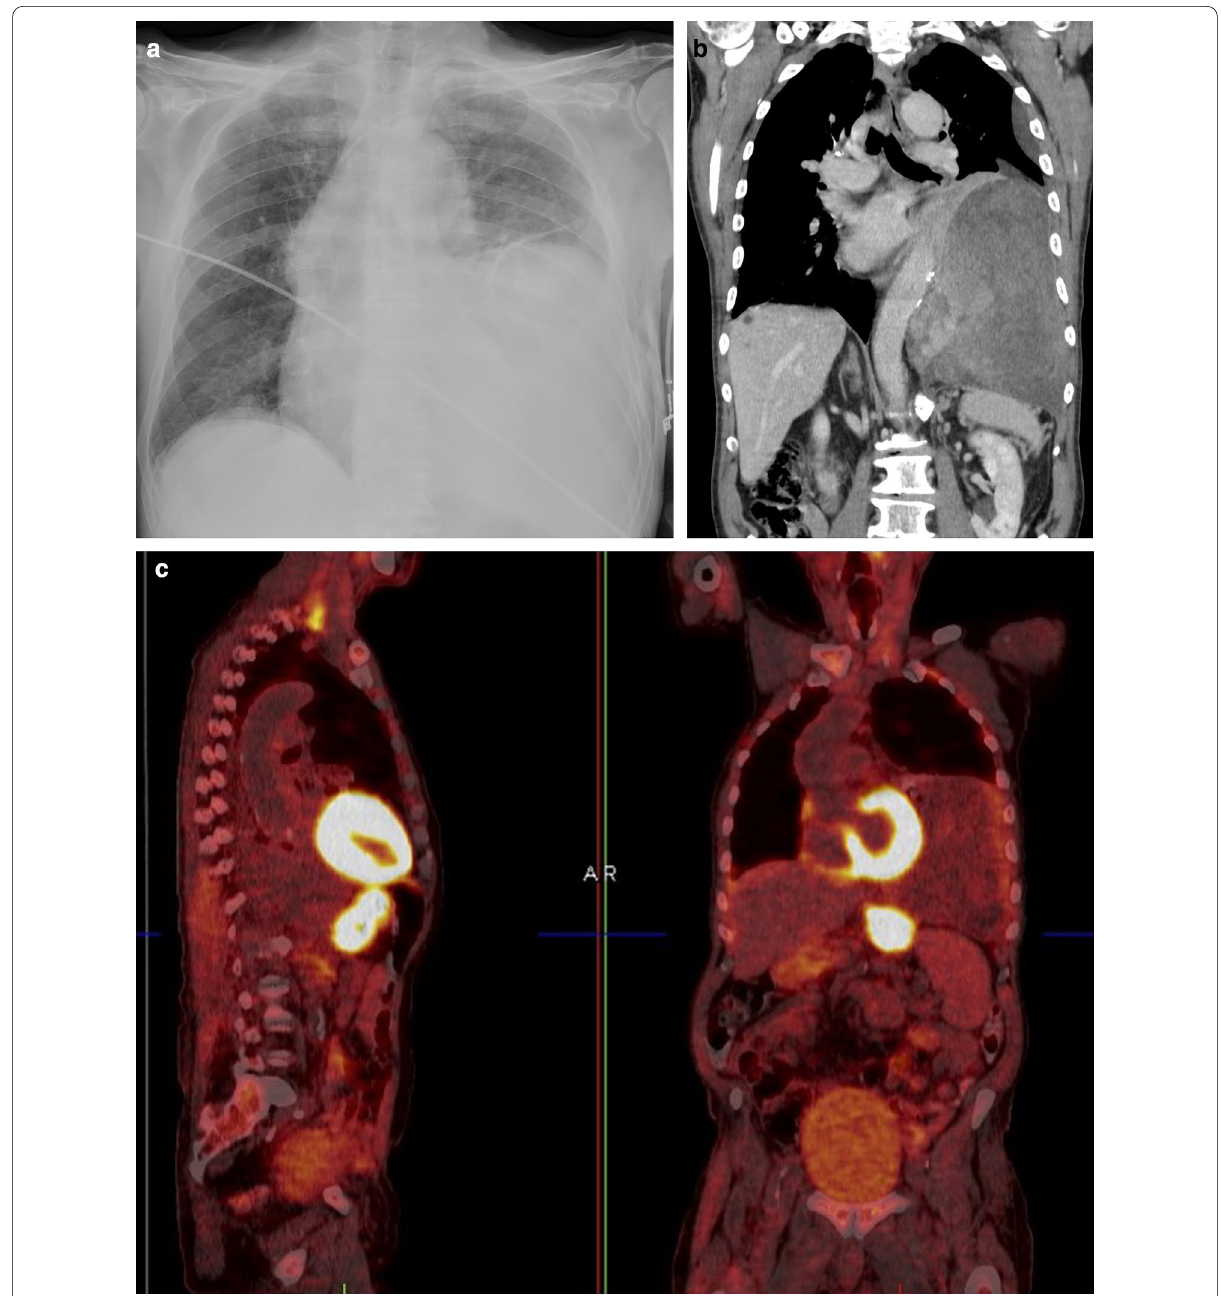
Fig. 5 Diagnosis: solitary fibrous tumor. Technique: standard chest radiography, contrast-enhanced chest CT and 18FDG-PET CT. Description: An 84-year-old man presented to the emergency department with clinical symptoms of weight loss, altered behavior, and fever. His bloodwork showed signs of hypoglycemia. Standard antero-posterior chest radiograph ( a ) shows a large area of consolidation in the left hemithorax, with a silhouette sign on the left heart border and left diaphragm. Coronal reformatted contrast-enhanced CT-image ( b ) shows a well-defined mass in the left hemithorax. The mass has a heterogeneous aspect with intralesional hypodense areas due to necrosis, cystic degeneration or myxoid component. The mass does not show an aggressive growth pattern: there are no imaging signs that suggest invasion in the adjacent thoracic aorta. There is no increased 18F-FDG uptake in the tumoral mass on the 18-F-FDG PET study ( c ). The combination of imaging findings and clinical findings was suggestive of Doege–Potter syndrome, which was confirmed after histopathologic examination of the large resected pleural